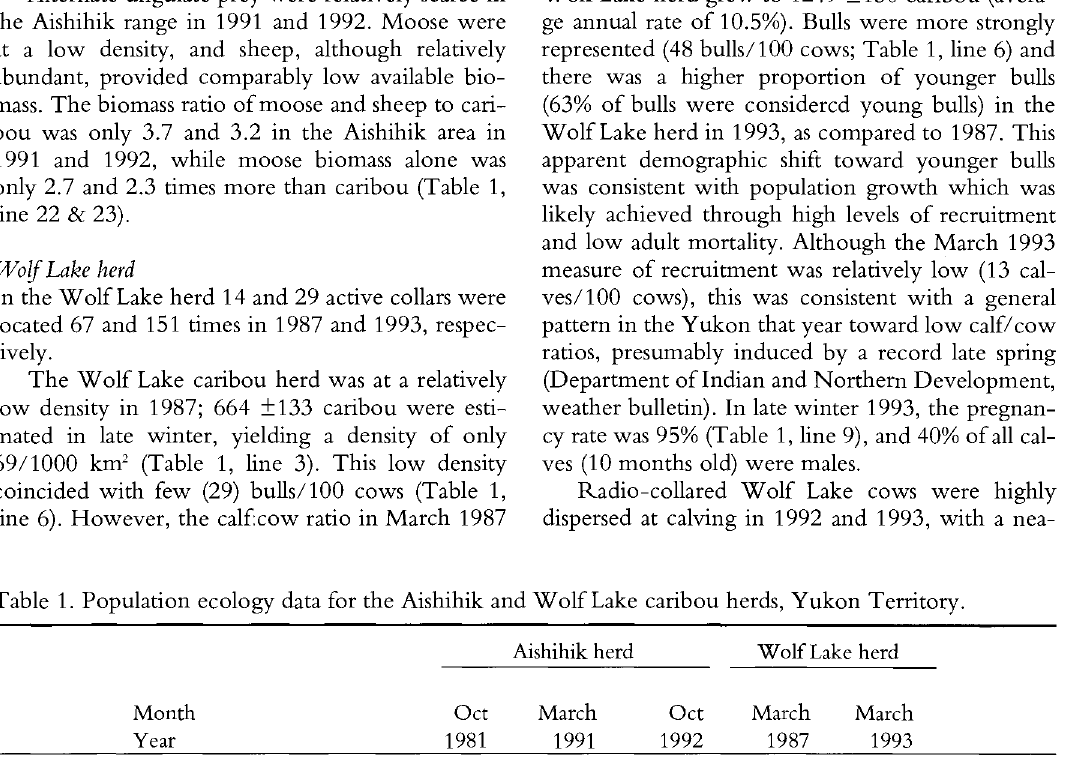
Table 1. Population ecology data for the Aishihik and Wolf Lake caribou herds, Yukon Territory. Aishihik